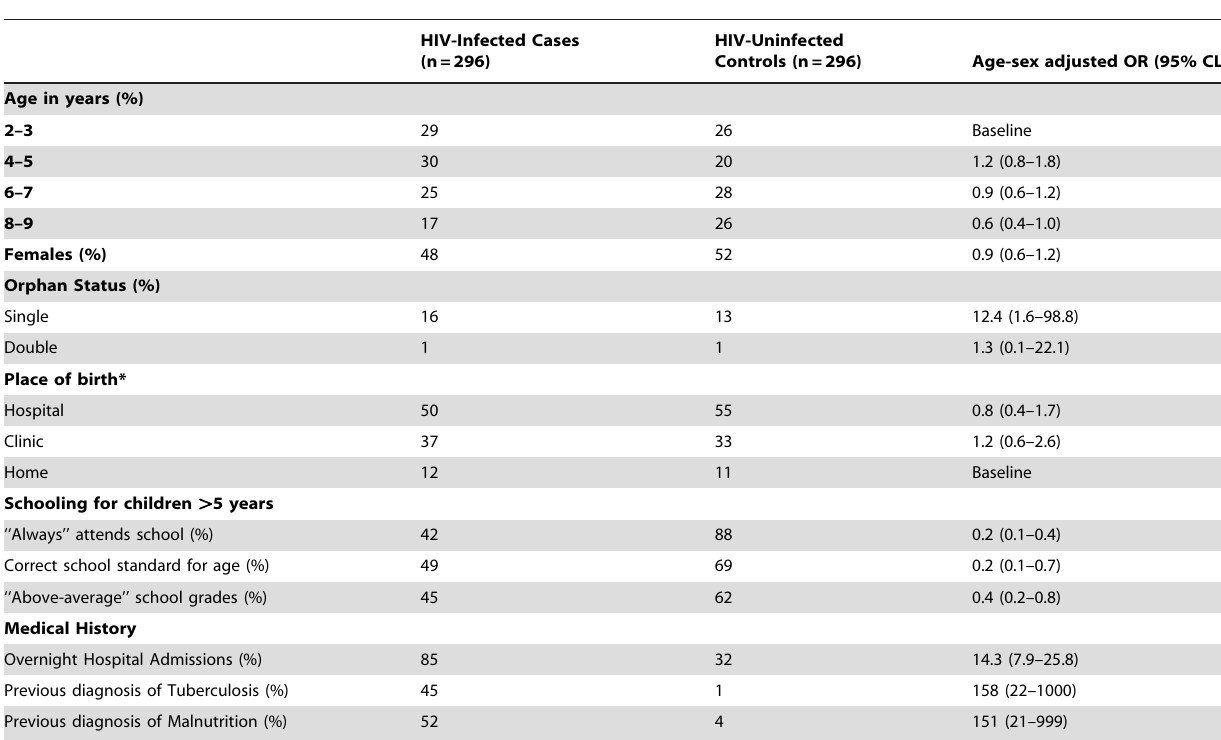
Table 1. Baseline characteristics of HIV-infected cases and HIV-uninfected